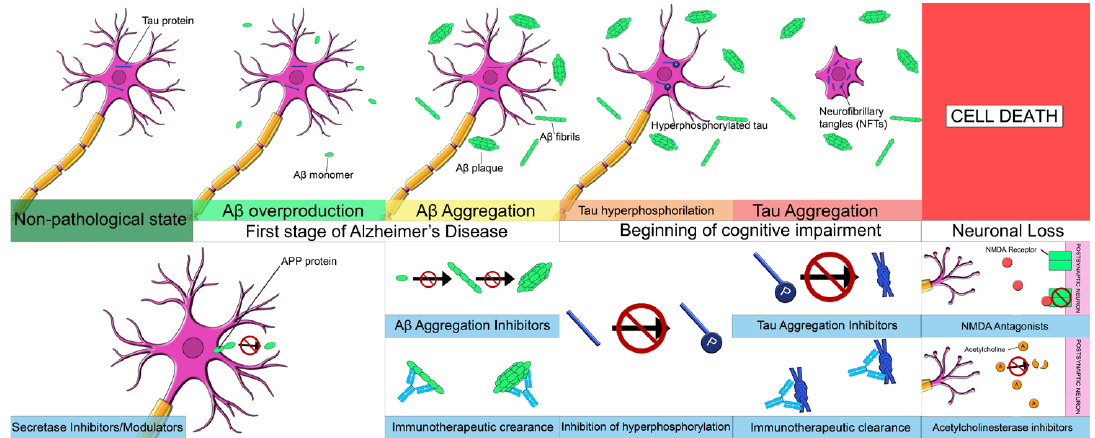
Figure 2. Molecular pathways involved in the pathology and in treatments under investigation for AD. Table 1. Pharmacological treatments under investigation related to Aβ pathology .